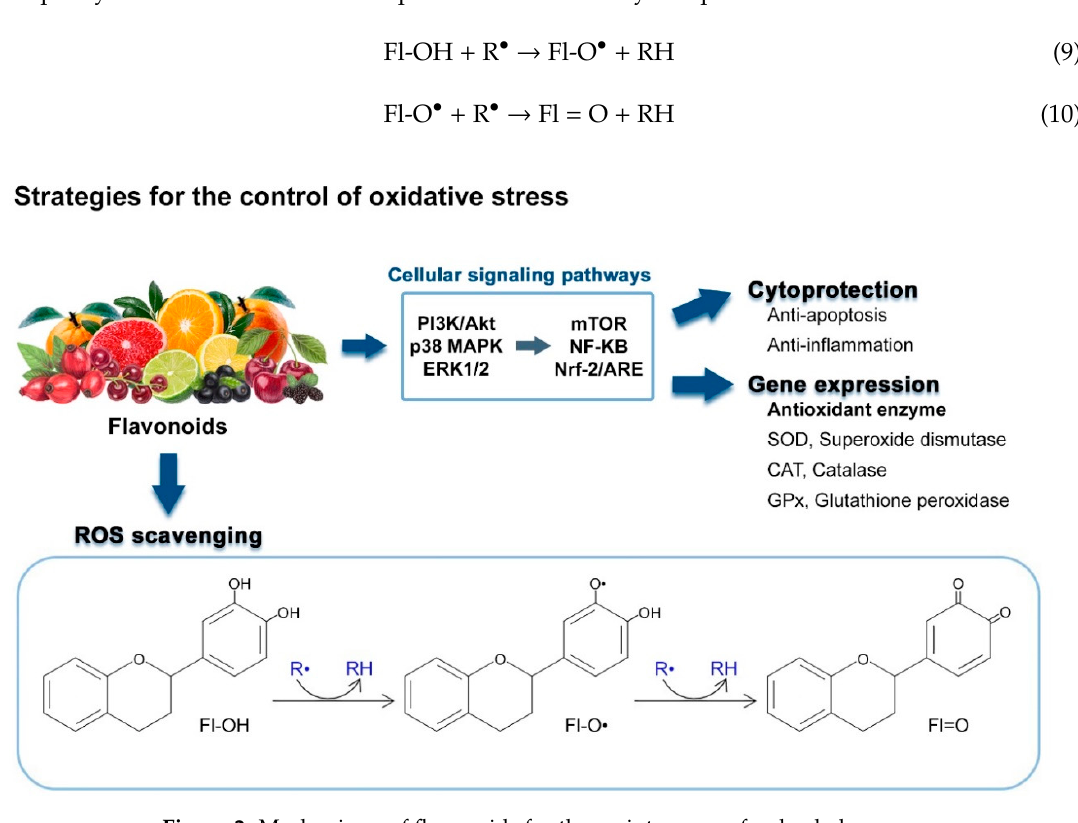
Figure 2. Mechanisms of flavonoids for the maintenance of redox balance.